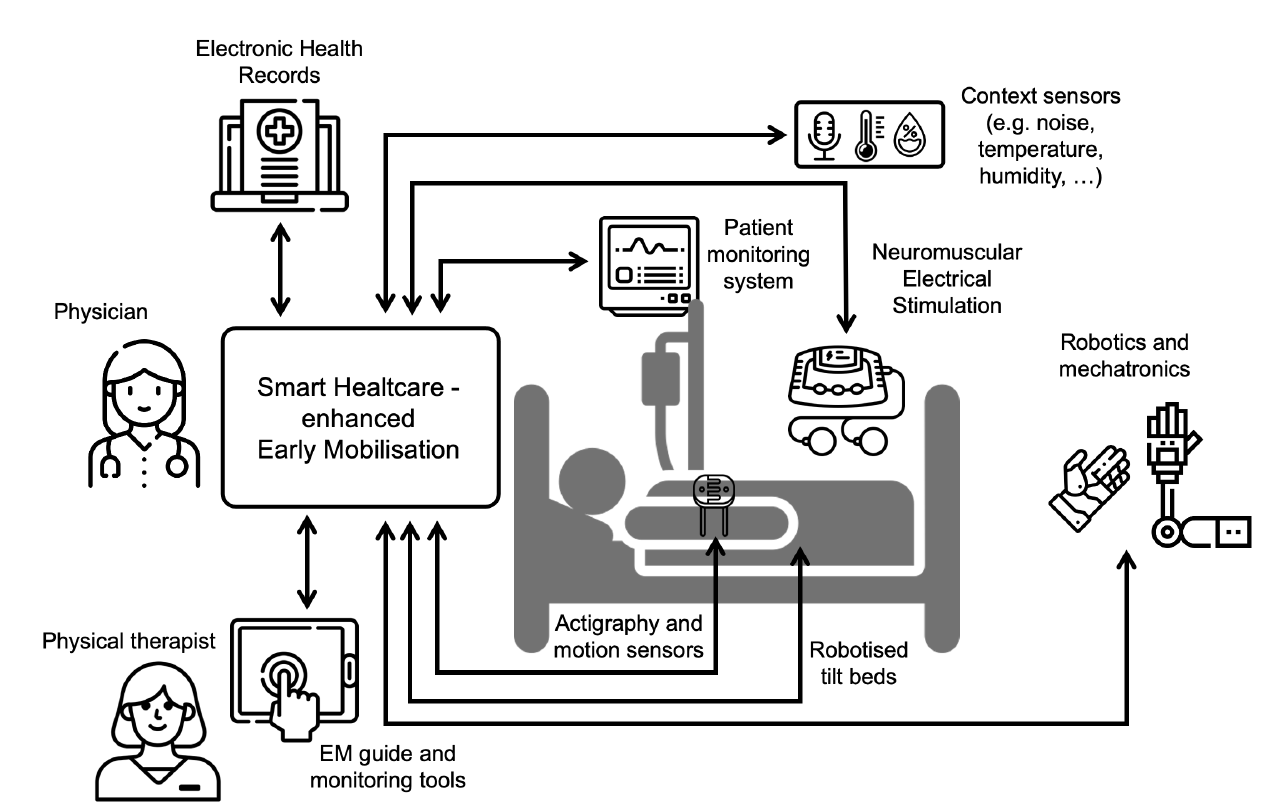
Figure 3. The components of a smart-healthcare-enhanced Early Mobilisation